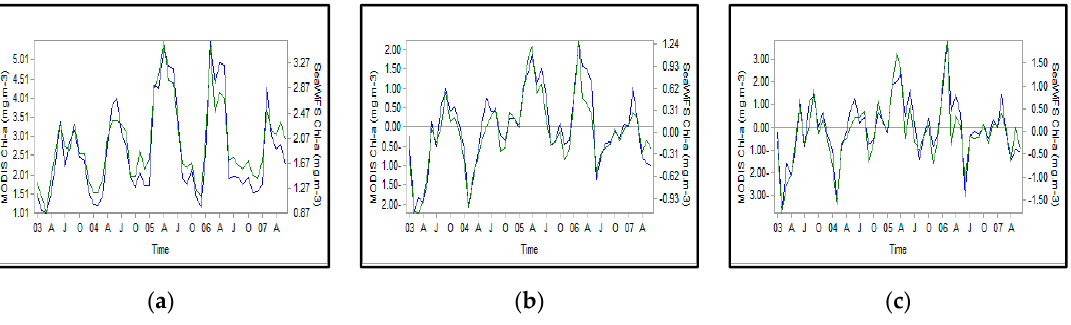
Figure A13. Pearson correlation coefficient for the Chl-a index in the Southern Caspian Sea during 2003-2007: ( a ) satellite data ( b ) anomalies, and ( c ) data after the prewhitening process.